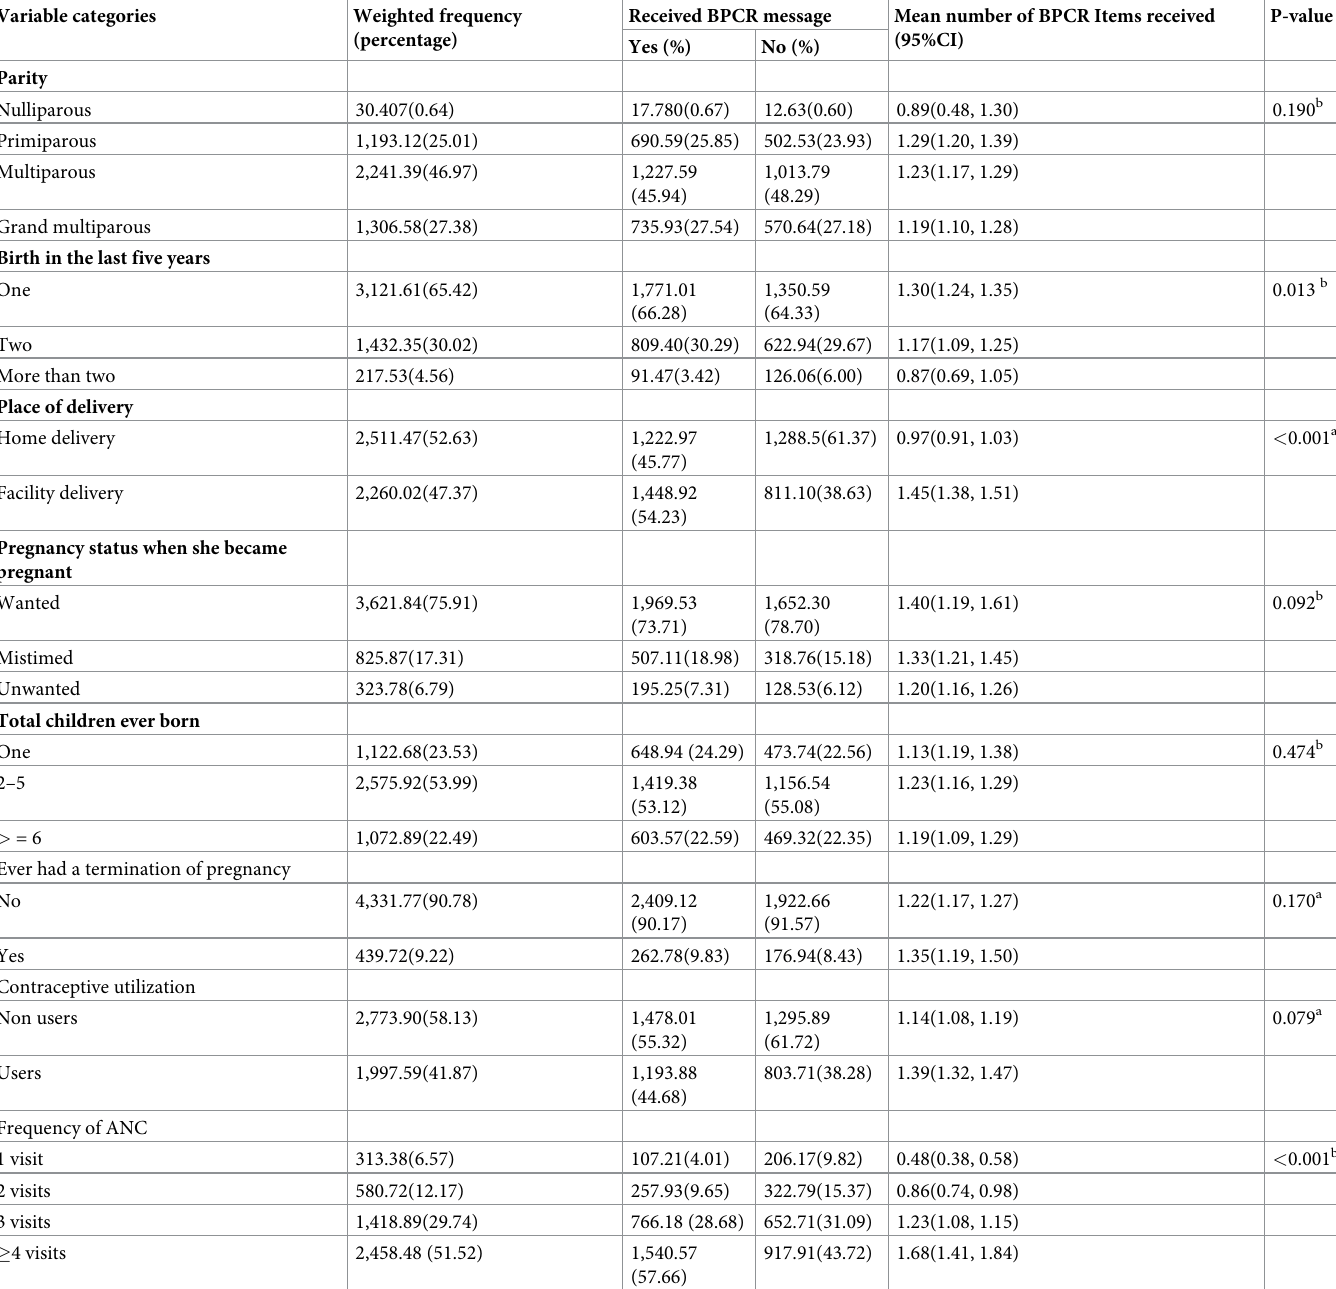
Table 2. Obstetric characteristics of women in the reproductive age group across the overall uptake and mean number of BPCR in Ethiopia,